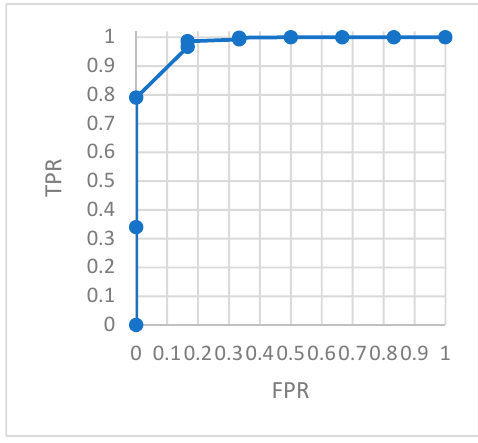
Figure 19. ROC of GRU-AE in test set 1.